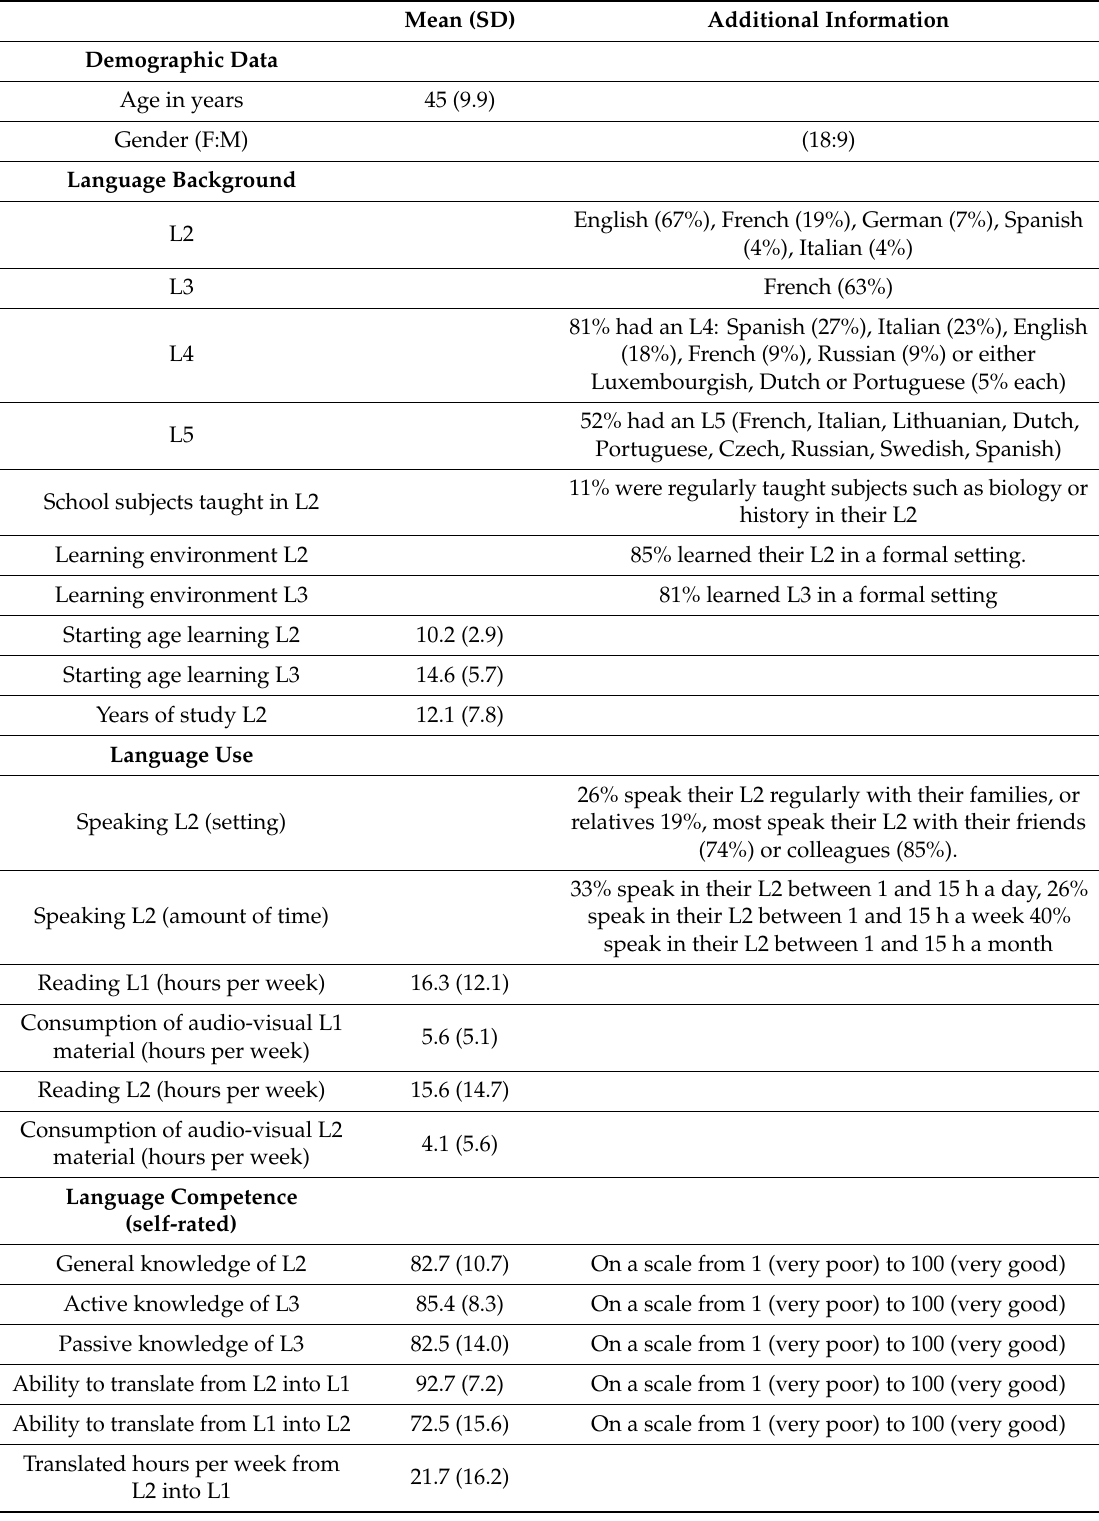
Table 2. Demographic and language history data of eye-tracking study